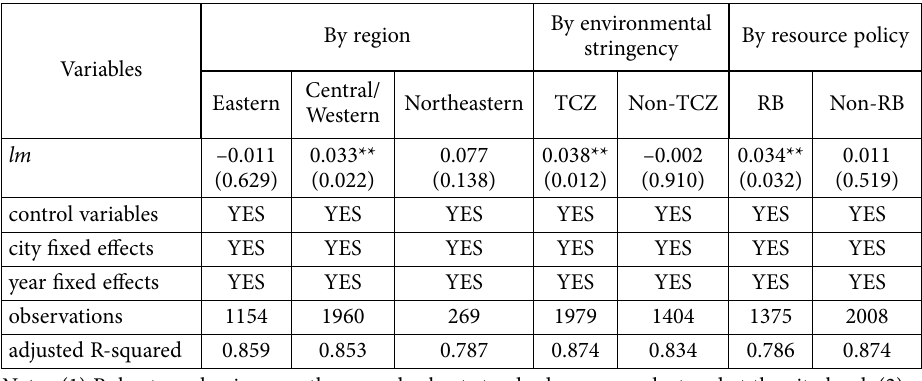
Table 4. Heterogeneity analysis